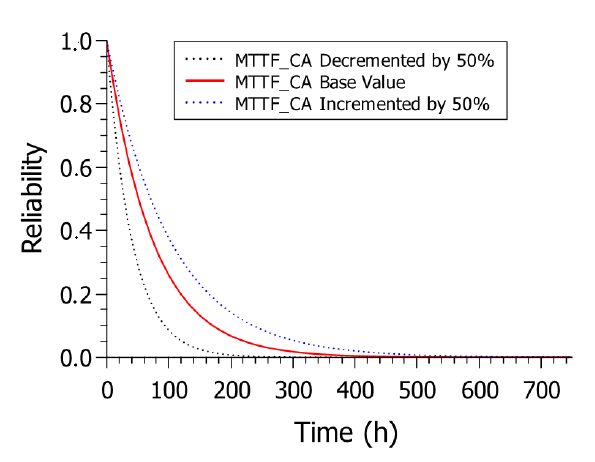
Figure 3. Reliability analysis.